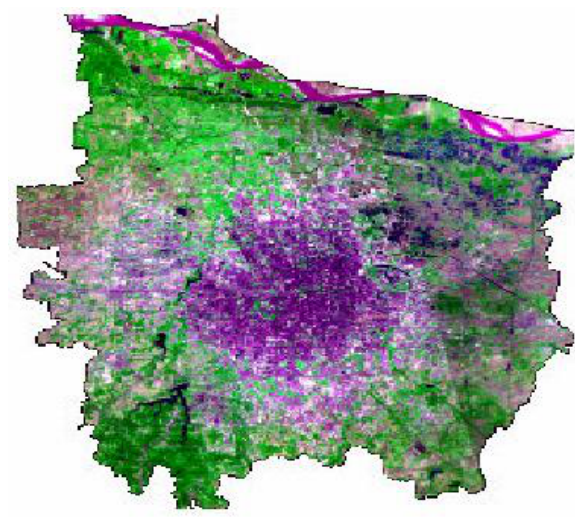
Fig. 2. Sharpening histogram